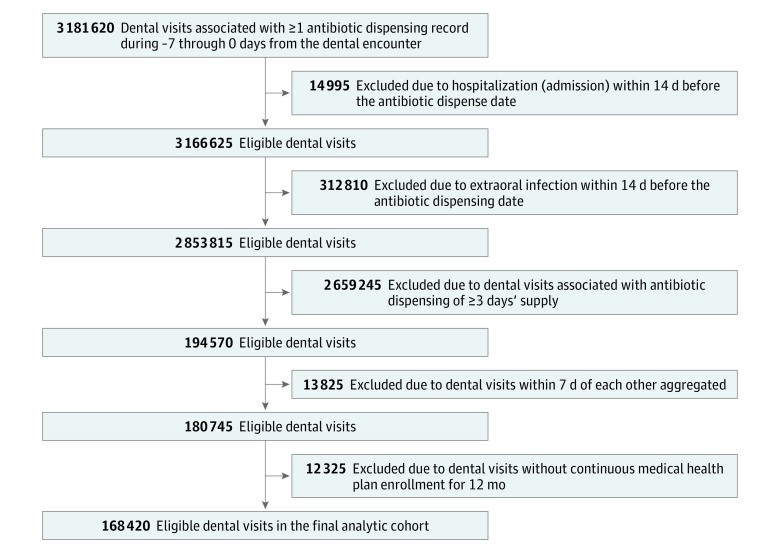
Study FlowchartDerivation of the study population is shown.